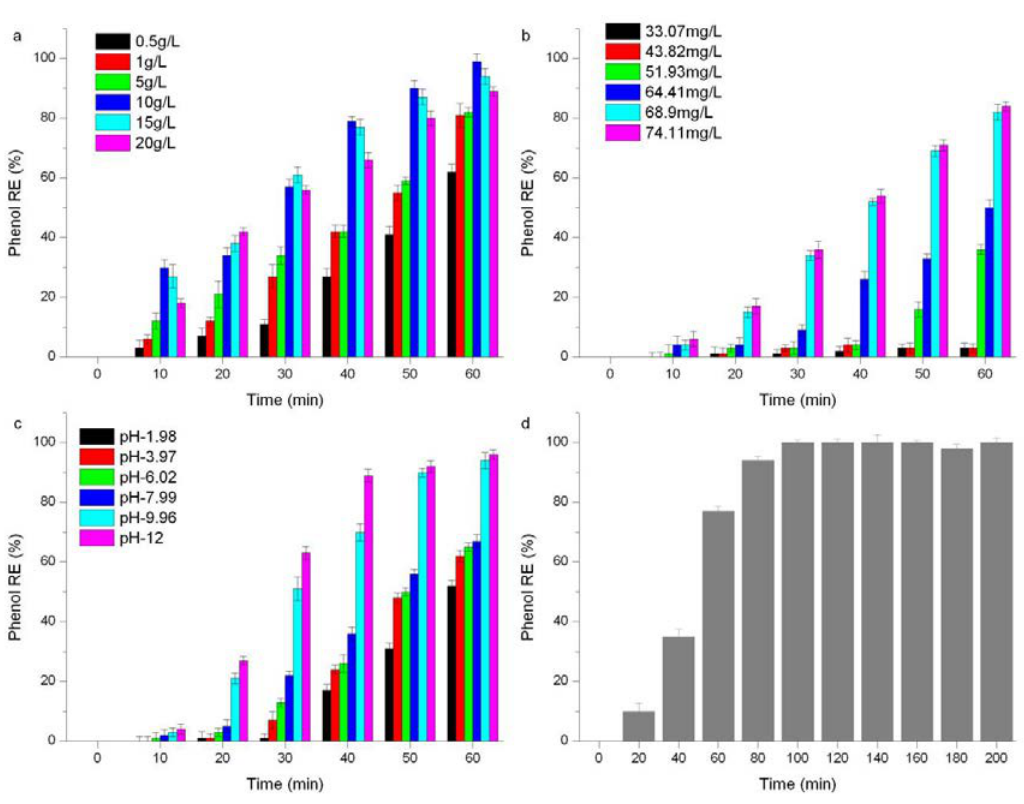
Figure 5. Effect of catalyst dosage ( a ), ozone concentration ( b ), initial pH ( c ) and reaction time ( d ) on the phenol degradation.